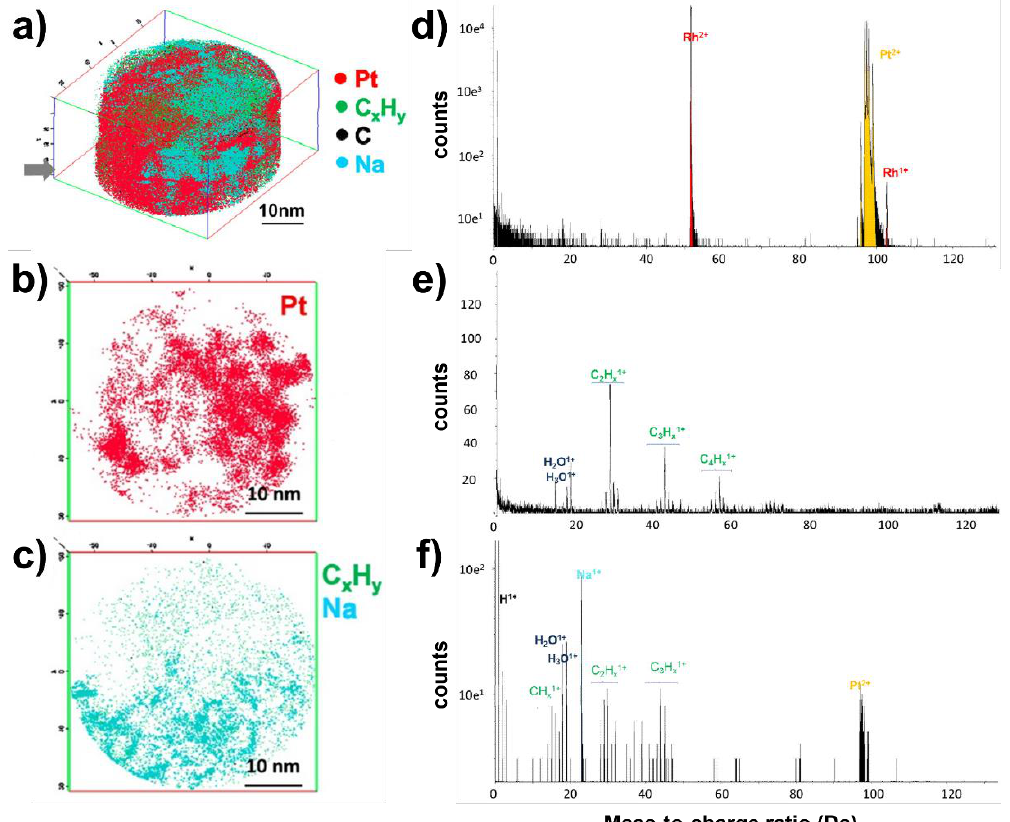
Figure 11. Investigation of C-supported Pt nanoparticles. ( a ) 3D reconstruction of the specimen presenting a complex morphology; 5 nm slice of the 3D map (from the grey arrow) representing the distribution of ( b ) Pt; and ( c ) C-based species and Na; mass spectra of a Pt-Rh tip sample ( d ) before any deposition where only Pt and Rh species are detected; ( e ) after deposition of C-support in methanol / water solution (in absence of Pt nanoparticles): only fragments of methanol (C 2 H x1 + , C 3 H x1 + , C 4 H x1 + ) and water (H 2 O 1 + , H 3 O 1 + ) are detected; ( f ) after deposition of C-supported Pt nanoparticles showing the presence of methanol and water fragment, as well as the expected Pt 1 + species and the non-expected Na 1 + from the synthesis. Reprinted with permission from [121]. Copyright (2014) American Chemical Society.